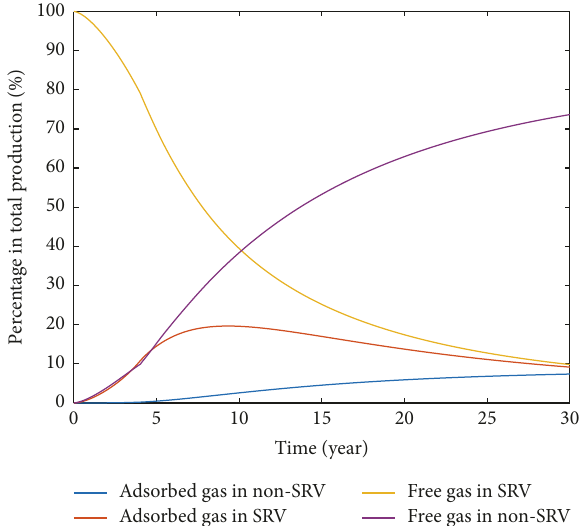
Figure 4: The fractions of free gas and absorbed gas in SRV and non-SRV regions in terms of production rate.